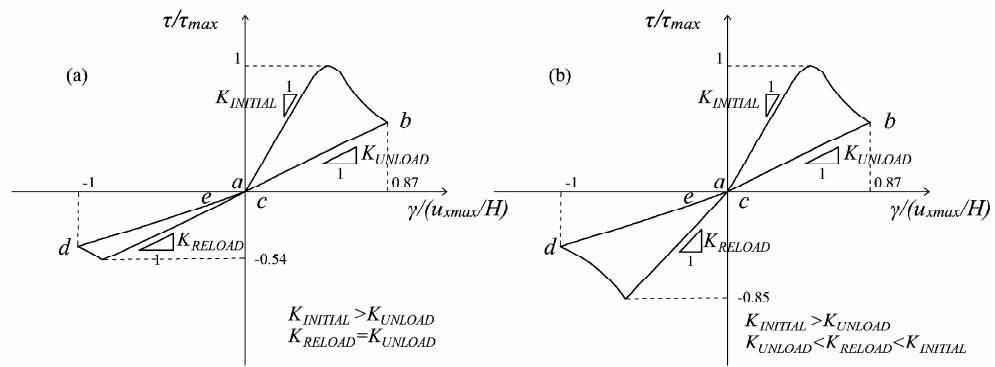
Figure 10. Structural response for the problem represented in Figure 5a, ratio m = 1.8: ( a ) damage formulation presented in Section 2 and ( b ) multidirectional damage model.